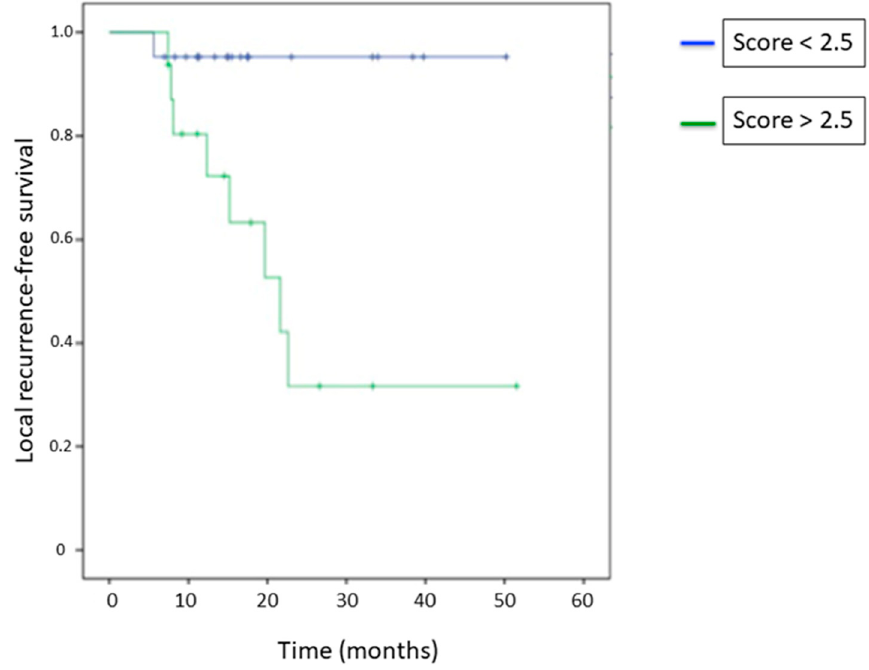
Figure 5. Local recurrence-free survival curves according to the threshold of 2.5.